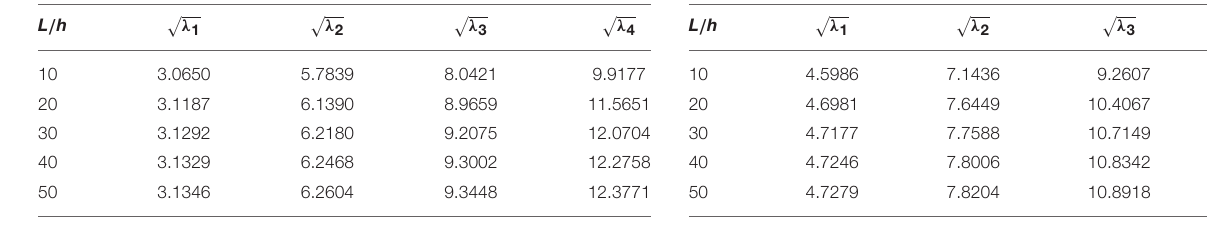
√ λ for SS case for different (cid:16) (cid:17)